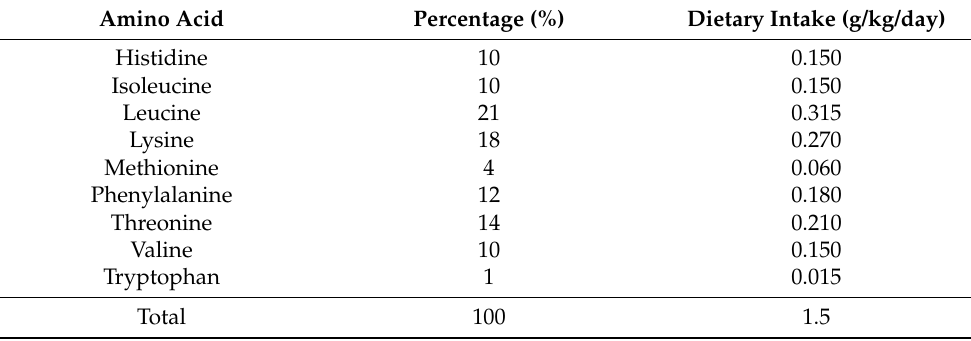
Table 1. Composition of essential amino